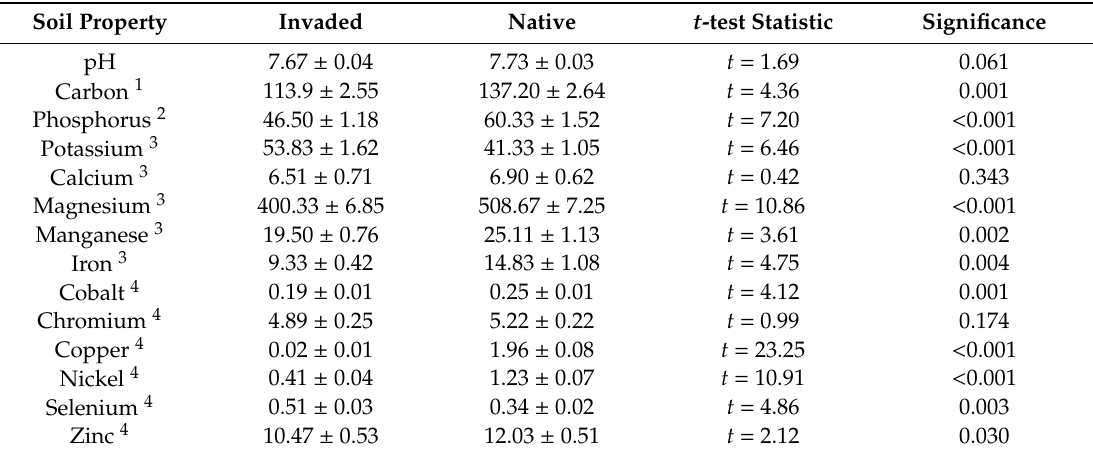
Table 3. The chemical properties of coastal sand soils within invaded mature stands of. Leucaena leucocephala and in adjacent native forest in central Guam. Means ± SE, n =